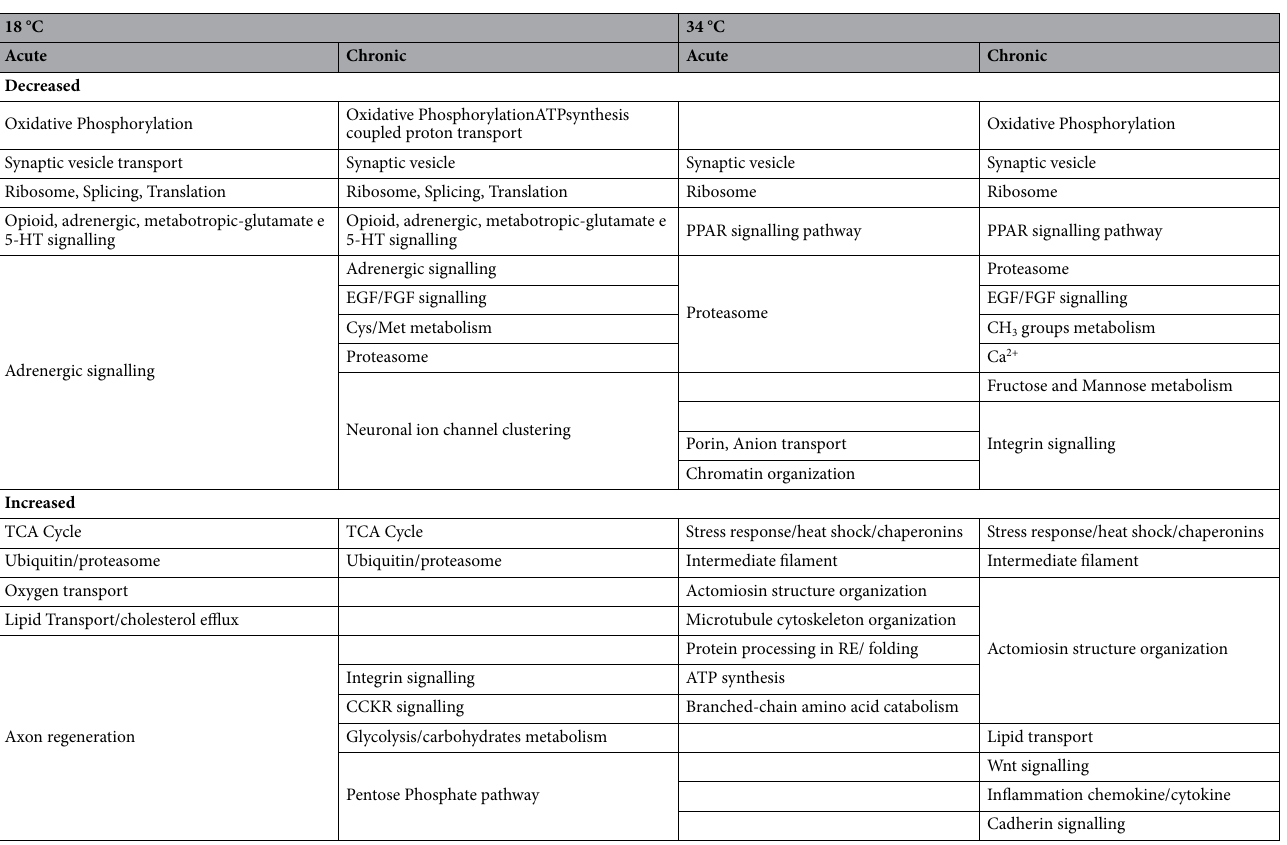
Table 1. Summary of the main findings from bioinformatic analysis by Panther, David and Cluego software programs. The analysis was carried out on the proteins differentially expressed (either up- or downregulated) or exclusively expressed under stress conditions with 26 °C as the control. Chronic refers to zebrafish kept at 18 °C or 34 °C for 21 d (mass spectrometric data published previously 14 ), while acute refers to zebrafish kept at the same temperatures for 4 d. Protein classification is based on GOBP, GOMF, KEGG and Pathway with P ≤ 0.05 and a minimum of 3